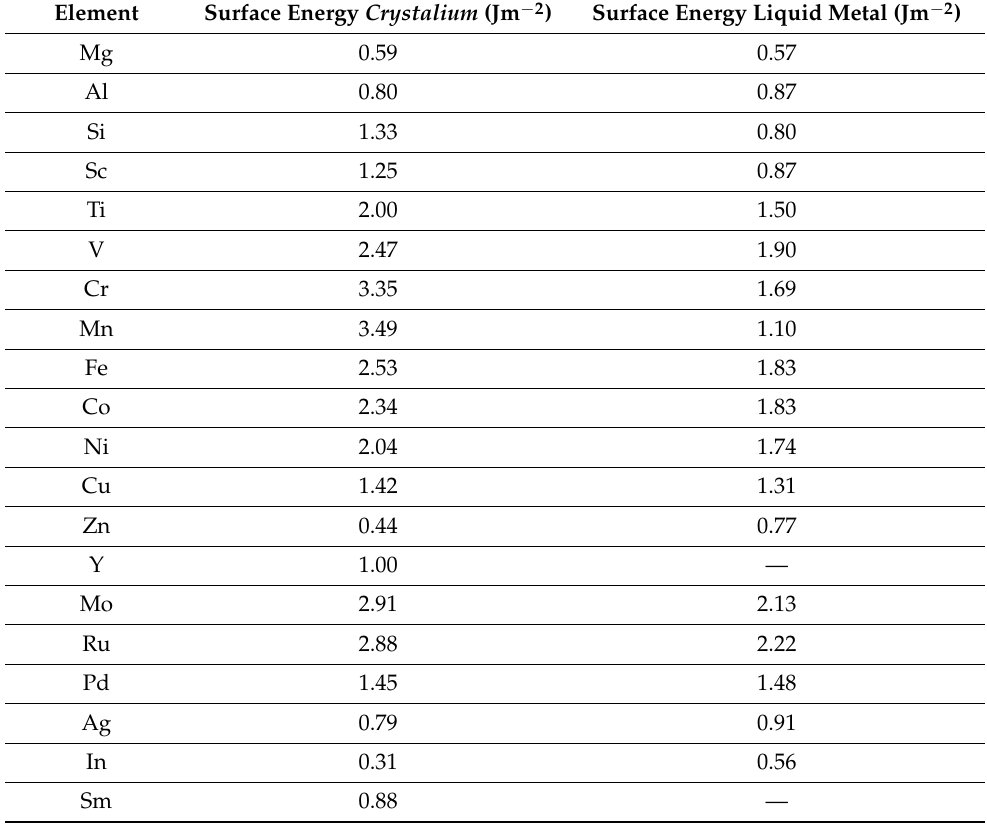
Table 3. Surface energies of the elements listed in Table